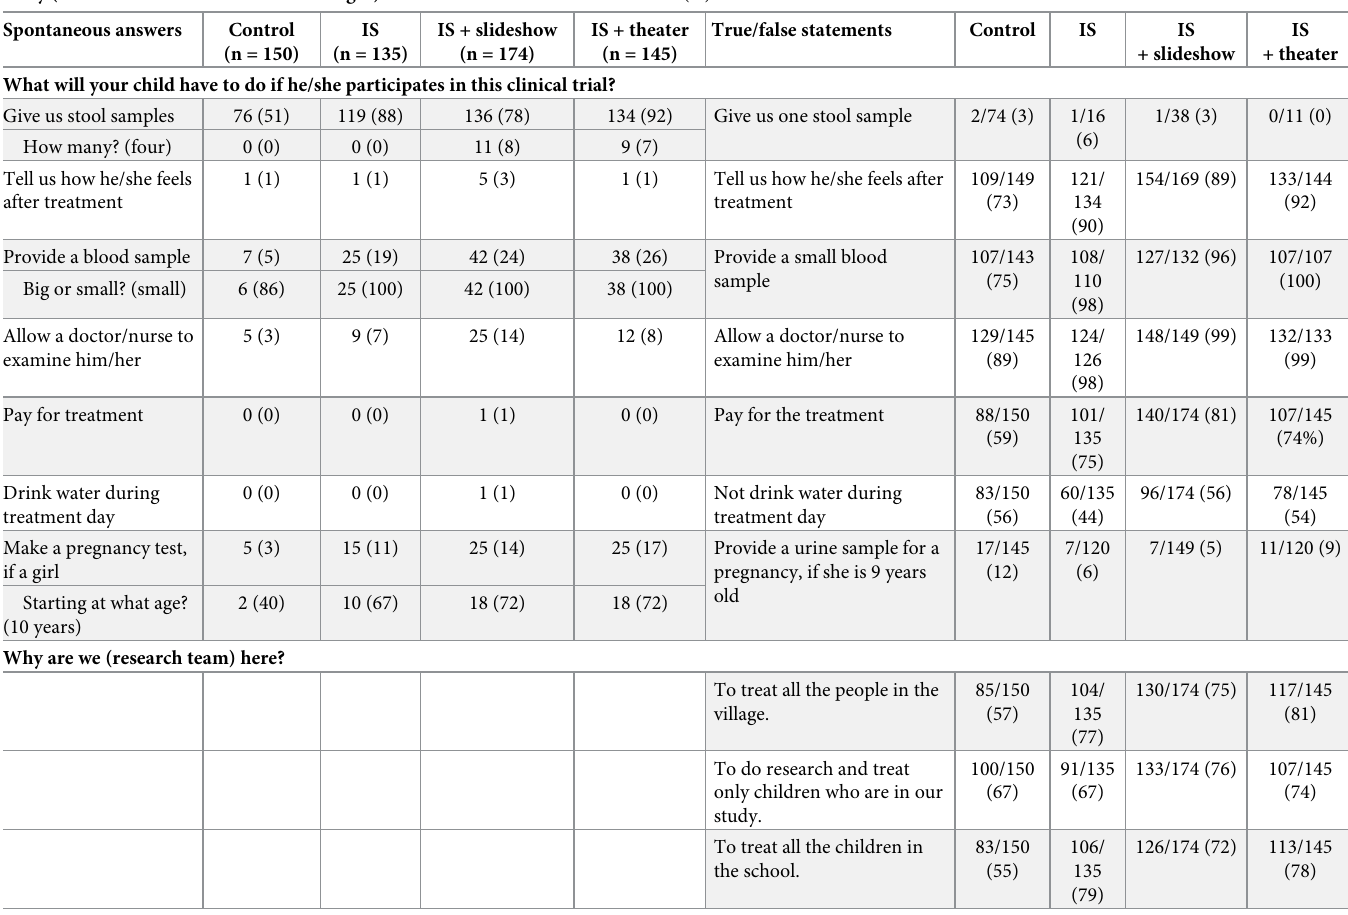
Table 4. Caregivers mentioning each of the key messages or responding correctly to the true/false statements concerning each key message not mentioned spontane- ously (Part B1 on the left and B2 on the right). IS = information session. Data are n (%). Spontaneous